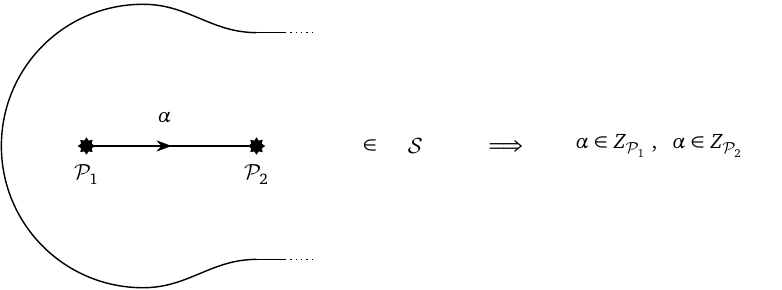
Figure 8: Top: The cycles in H some element of (cid:98) Z . Bottom: Composition rule for cycles that end on punctures.